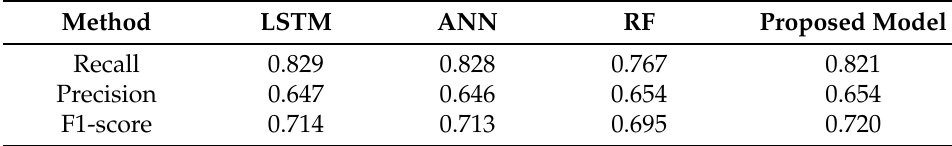
Figure 9. Average of F1-scores for PM 2.5 3 and 5 h predictions at Locations A and B. Table 2. Model prediction performances after 3 h at Location A.